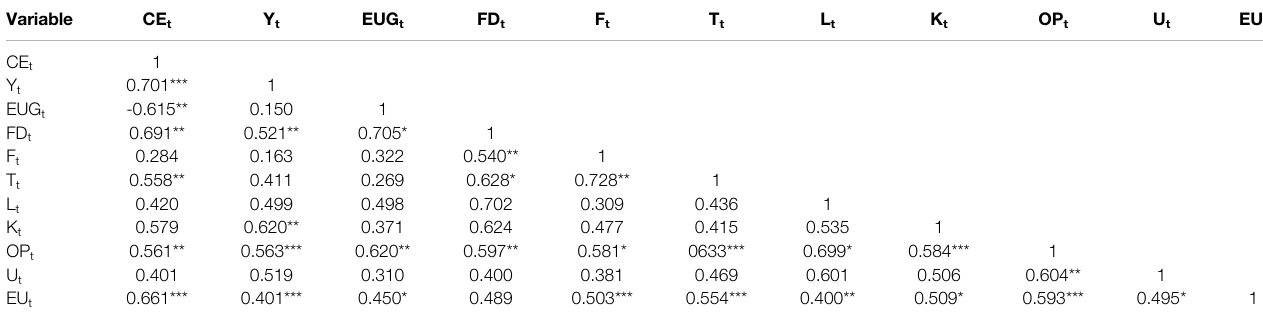
TABLE 2 | Variable correlations. Variable